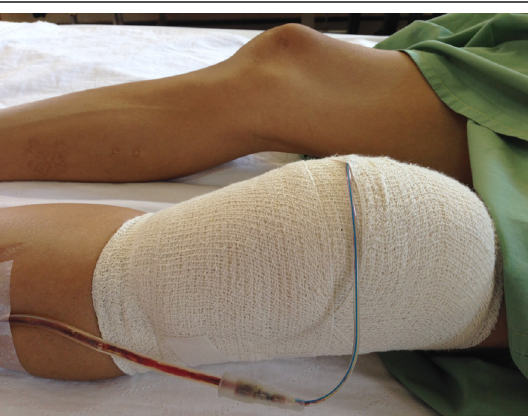
Figure 2. Patient’s Left Knee with Effusion that had been Ban- daged and Drained.